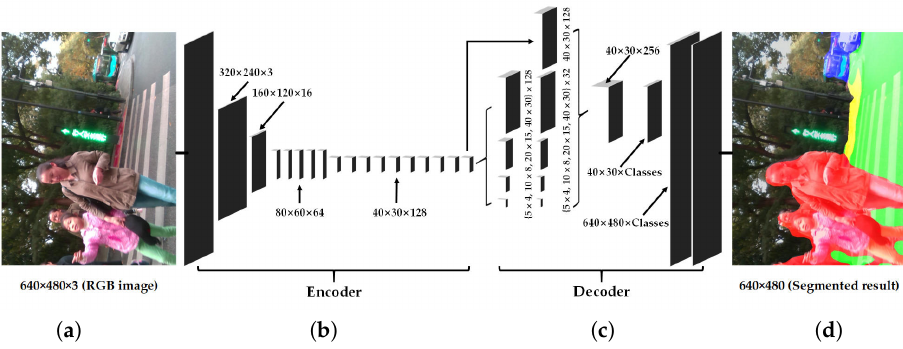
Figure 5. The proposed architecture. From left to right: ( a ) input, ( b ) encoder, ( c ) decoder and ( d )